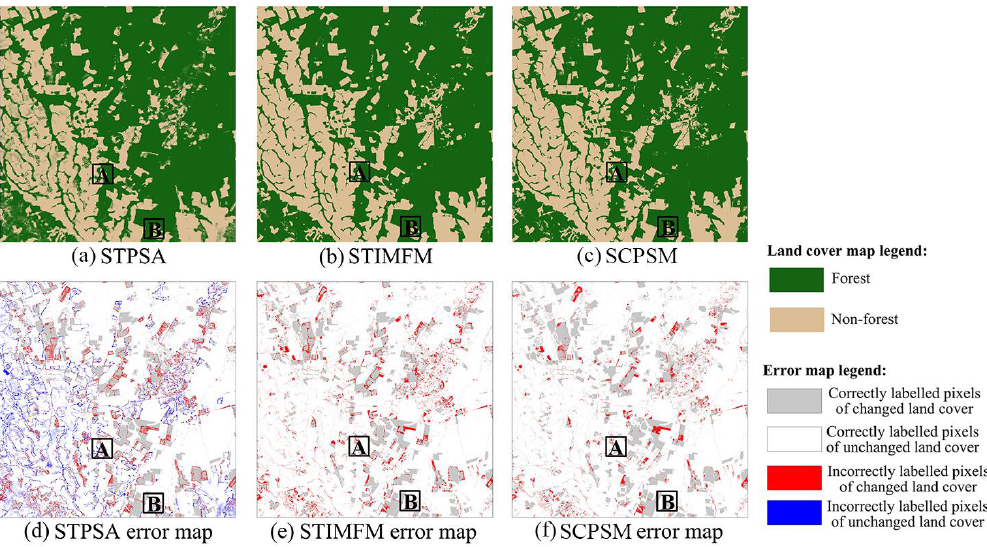
Figure 10. The land cover maps predicted from different methods and the corresponding error maps in the forest clearance experiment. ( a ) STPSA; ( b ) STIMFM; ( c ) SCPSM; ( d ) STPSA error map; ( e ) STIMFM error map; ( f ) SCPSM error map.